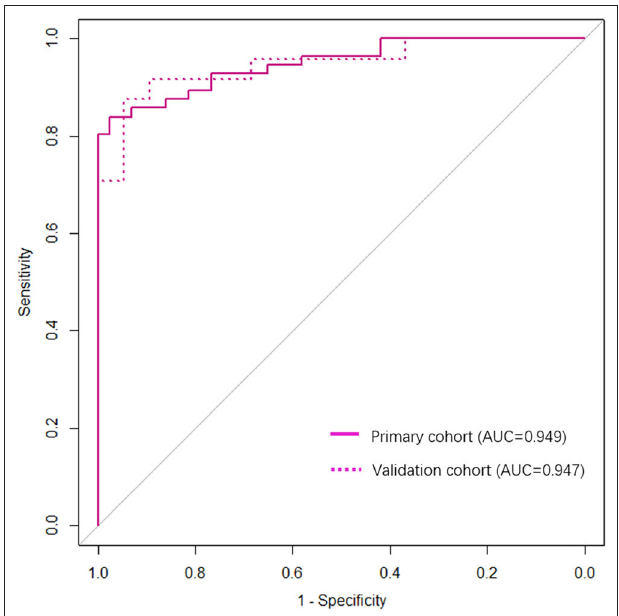
FIGURE 3 | Receiver operating characteristic (ROC) based on clinical–radiomics nomogram.